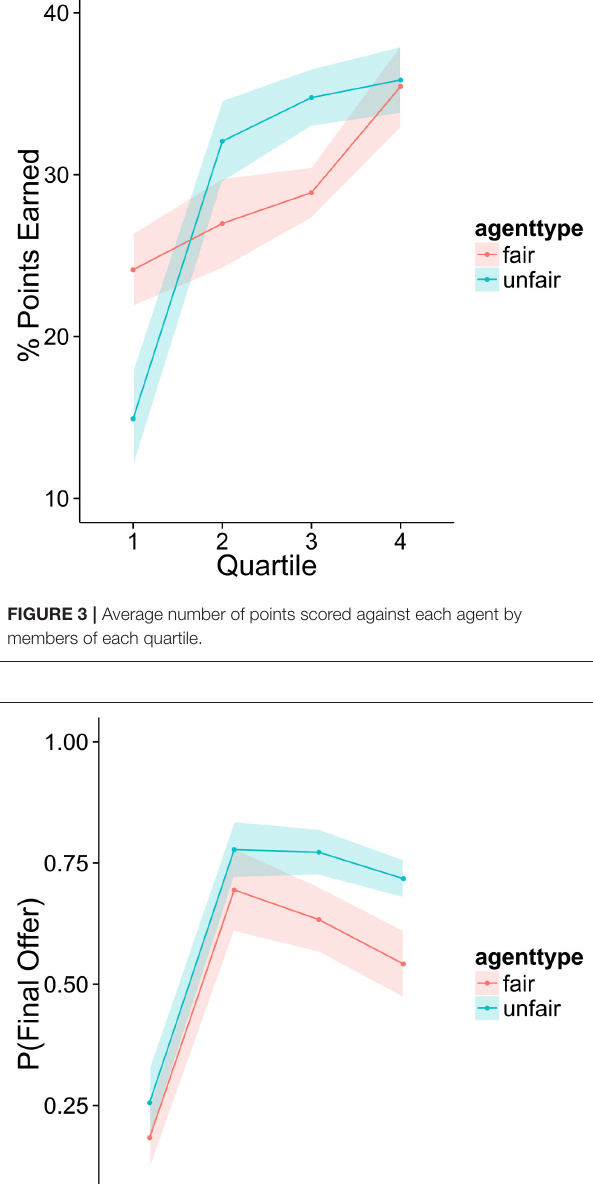
TABLE 3 | Results of GLME analysis on use of final offers.